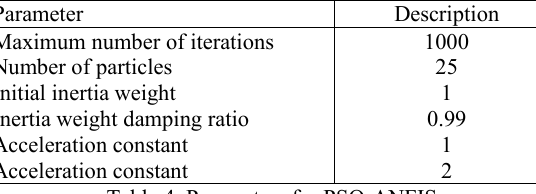
Table 4. Parameters for PSO-ANFIS